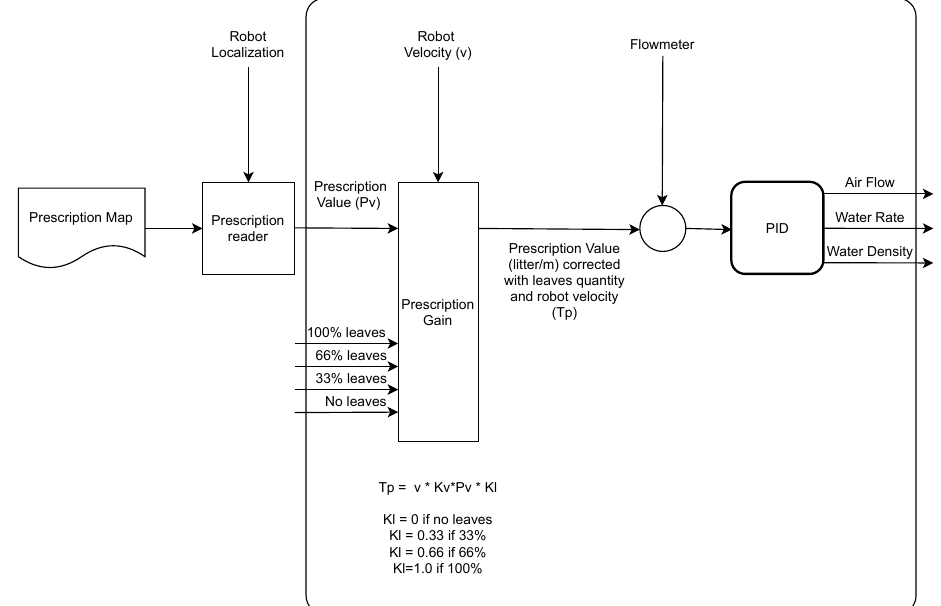
Figure 9. Controller